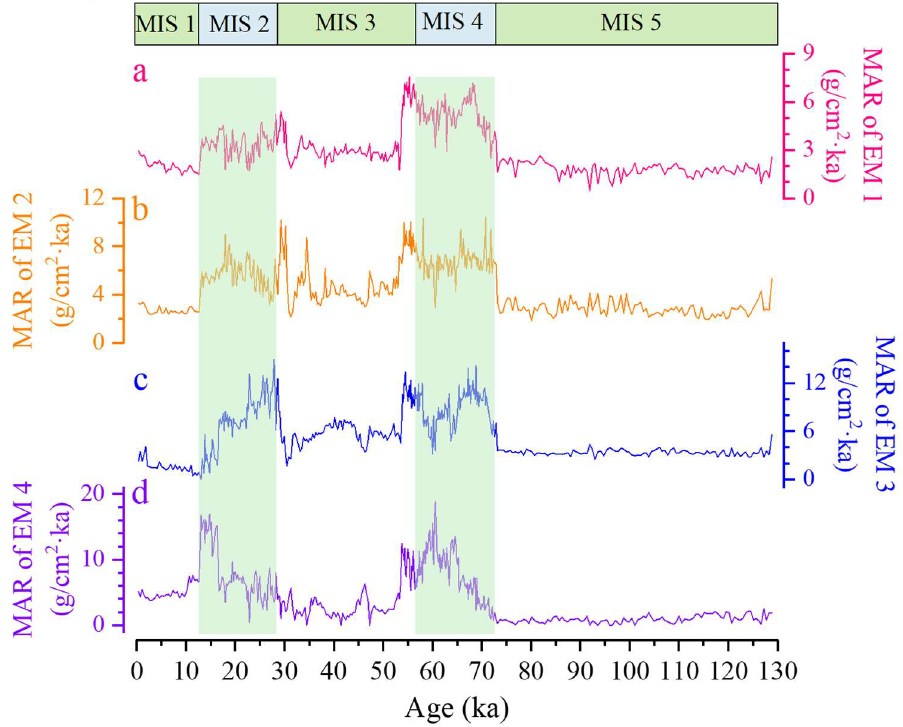
Figure 5. Variations in the mass accumulation rate (MAR) of ( a ) EM1, ( b ) EM2, ( c ) EM3, and ( d ) EM4. MIS: marine isotope stages.